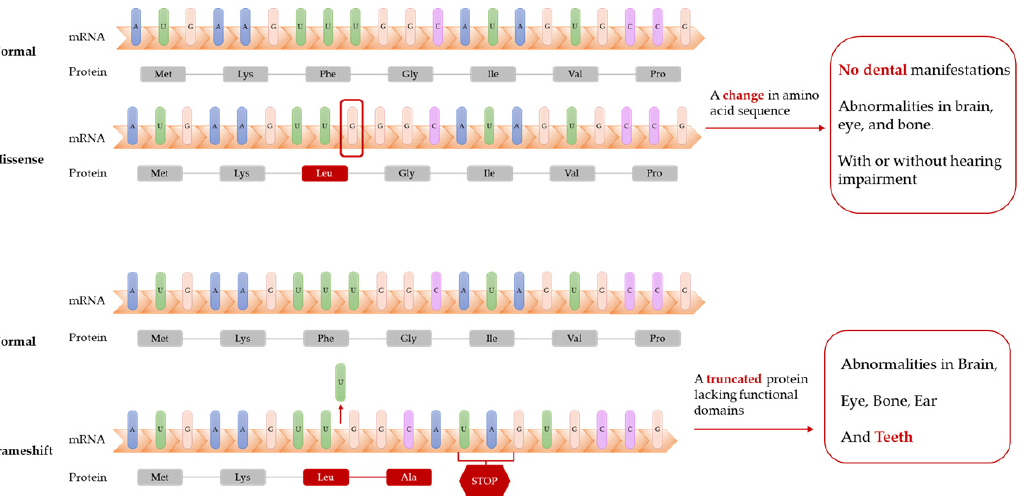
Figure 4. Frameshift mutations of LONP1 gene lead to truncated proteins. Patients with these mutations have dental abnormalities (delayed tooth eruption and cusp elongation), while patients with missense mutations of LONP1 gene might not have dental manifestations. Table 1. Mutation details of the LONP1 gene in CODAS patients with dental abnormalities.